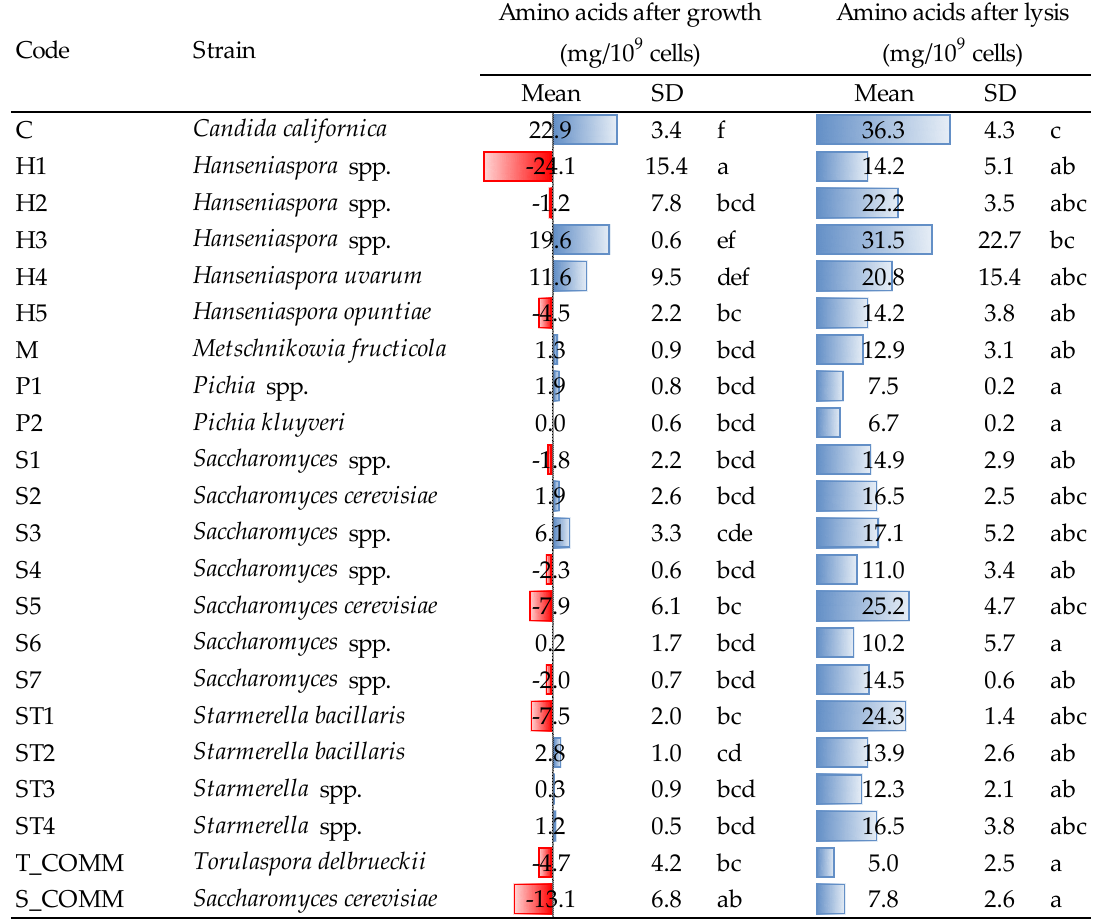
Figure 3. Amount of amino acids released by the different strains after growth (48 h, YPD medium, 30 ◦ C) and after lysis induced by β -glucanase enzymes. Data are means and standard deviations (SD) of three repetitions. Different letters mark significant differences according to ANOVA and Tukey HSD test at p < 0.05. T_COMM, S_COMM: commercial active dry yeast preparations. Concerning the values detected after growth, positive and negative values (blue and red bars) indicate, respectively, an increase/production or a decrease/consumption, with respect to the initial composition of the YPD medium.